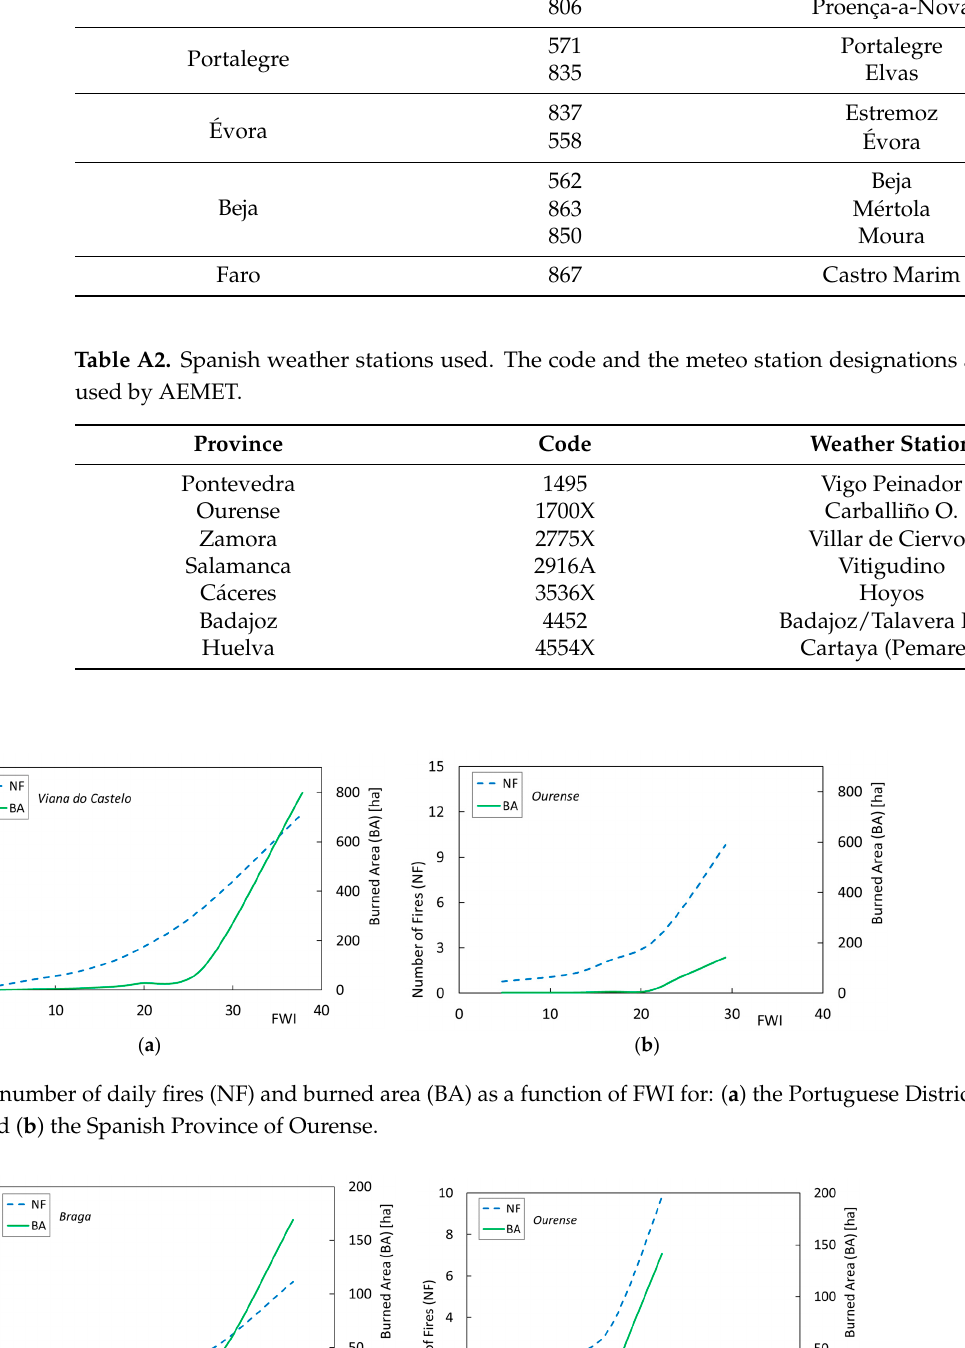
Figure A2. Average number of daily fires (NF) and burned area (BA) as a function of FWI for: ( a ) the Portuguese District of Braga and ( b ) the Spanish Province of Ourense.